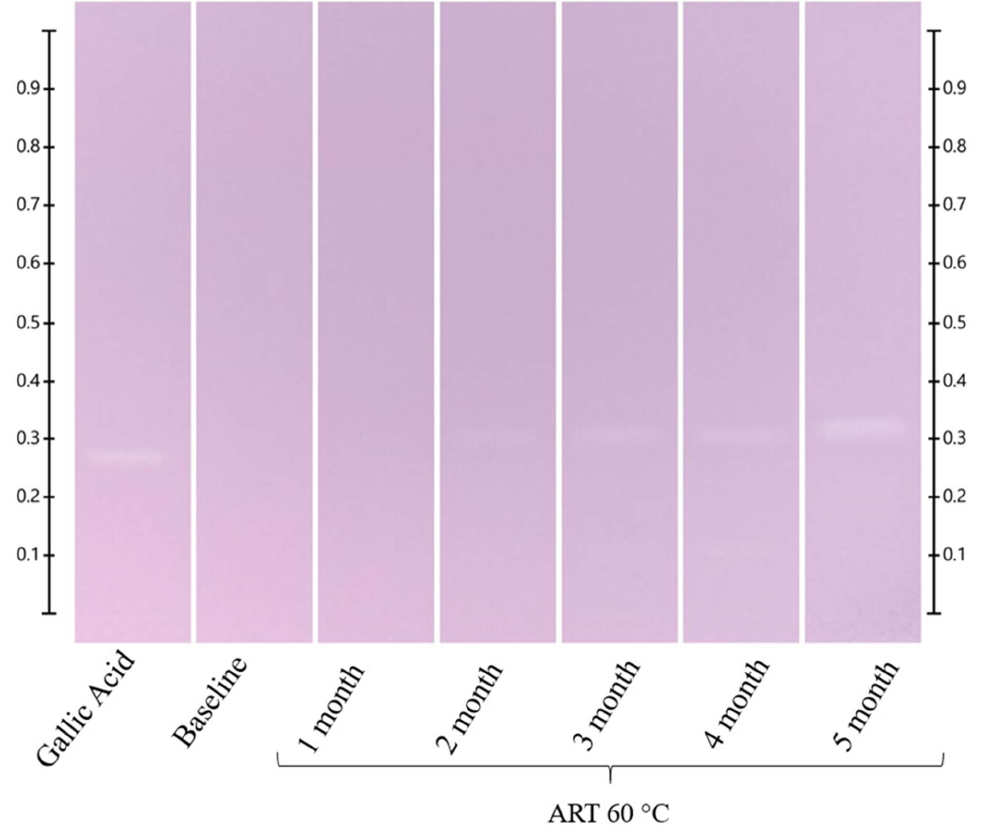
Figure 8. HPTLC-DPPH fingerprints of ART honey stored at 60 °C for up to 5 months. Images of the HPTLC plate were taken under white light after 60 min of derivatization with DPPH* reagents, gallic acid (4 μL) and honey extracts (5 μL) respectively.